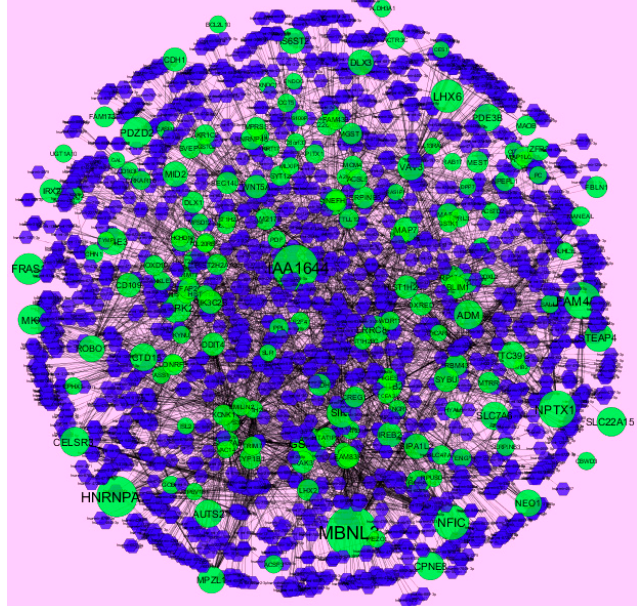
Figure 12. The network of up-regulated DEGs and their related miRNAs. The green circles nodes are up-regulated DEGs, and blue diamond nodes are miRNAs. Black lines means interaction with adjutant genes or miRNAs.